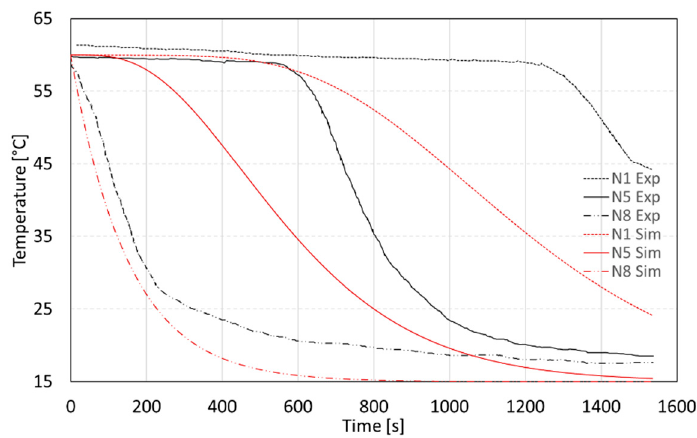
Figure 16. Reference node (#5) splitting for the investigation of the influence that node volume plays on model accuracy (heights in millimeters).